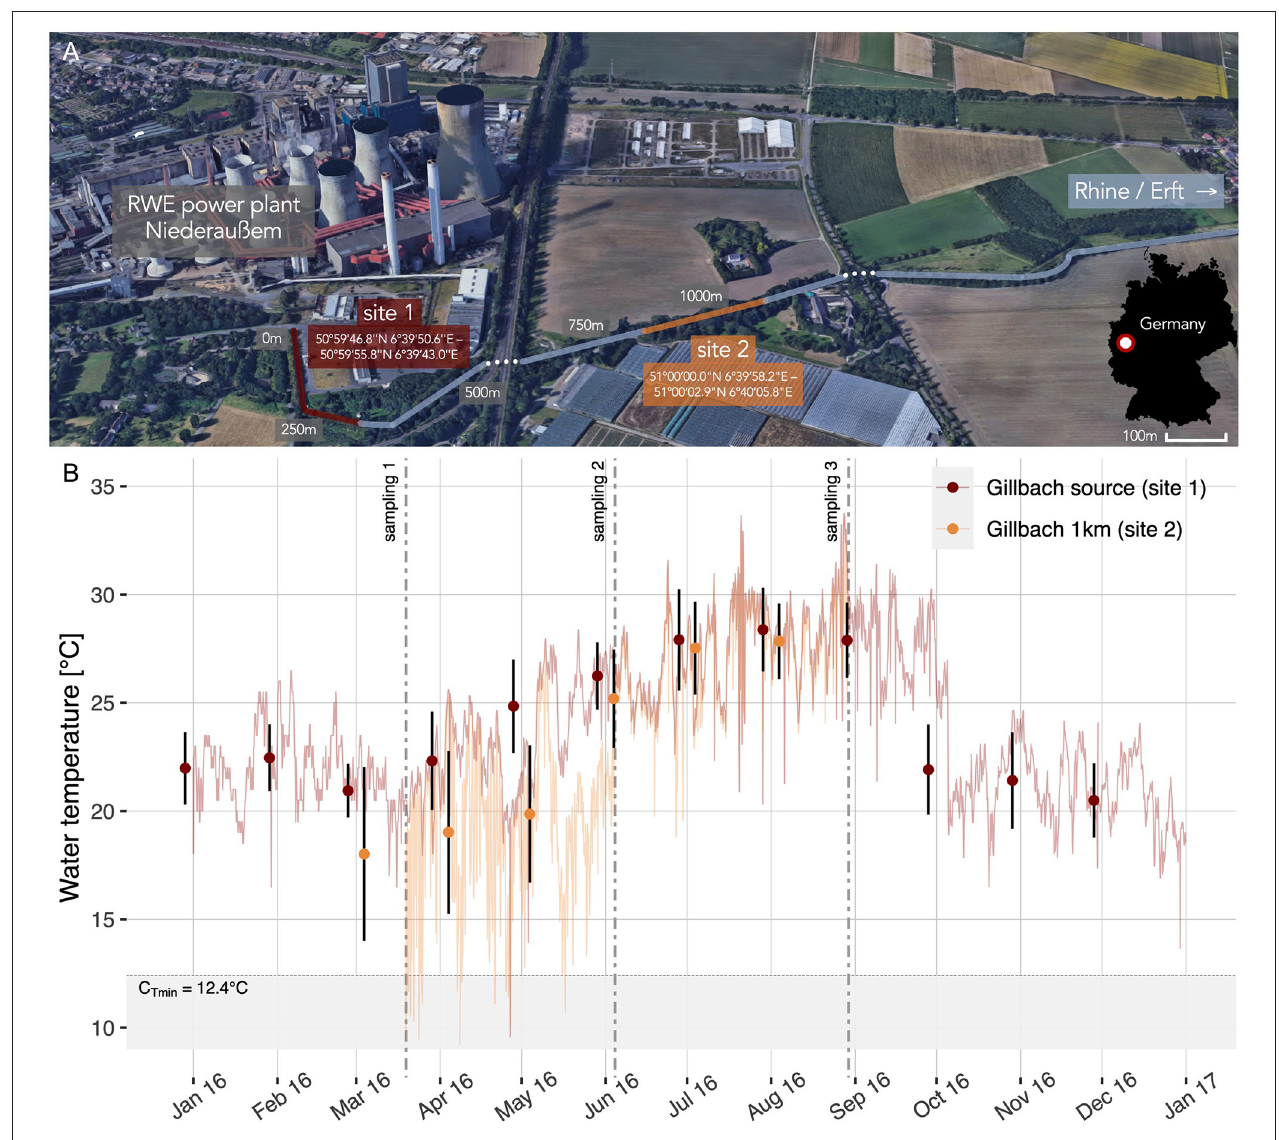
FIGURE 1 | The Gillbach stream and its altered temperature regime. (A) Warm water discharge from a power plant feeds into the Gillbach (map created using © Google Earth; Imagery © 2019 Google, Map data © 2009 GeoBasis-DE/BKG) and generates a thermal gradient above ambient water temperatures that is